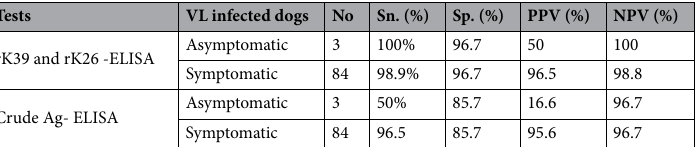
Table 5. Sensitivity, specificity, positive predictive value, and negative predictive value of Crude Ag and mixed rK39 and rK26—antigens compared to DAT for serodiagnosis of symptomatic and asymptomatic VL infected dogs. Sn Sensitivity, Sp Specificity, PPV Positive predictive value, NPV Negative predictive